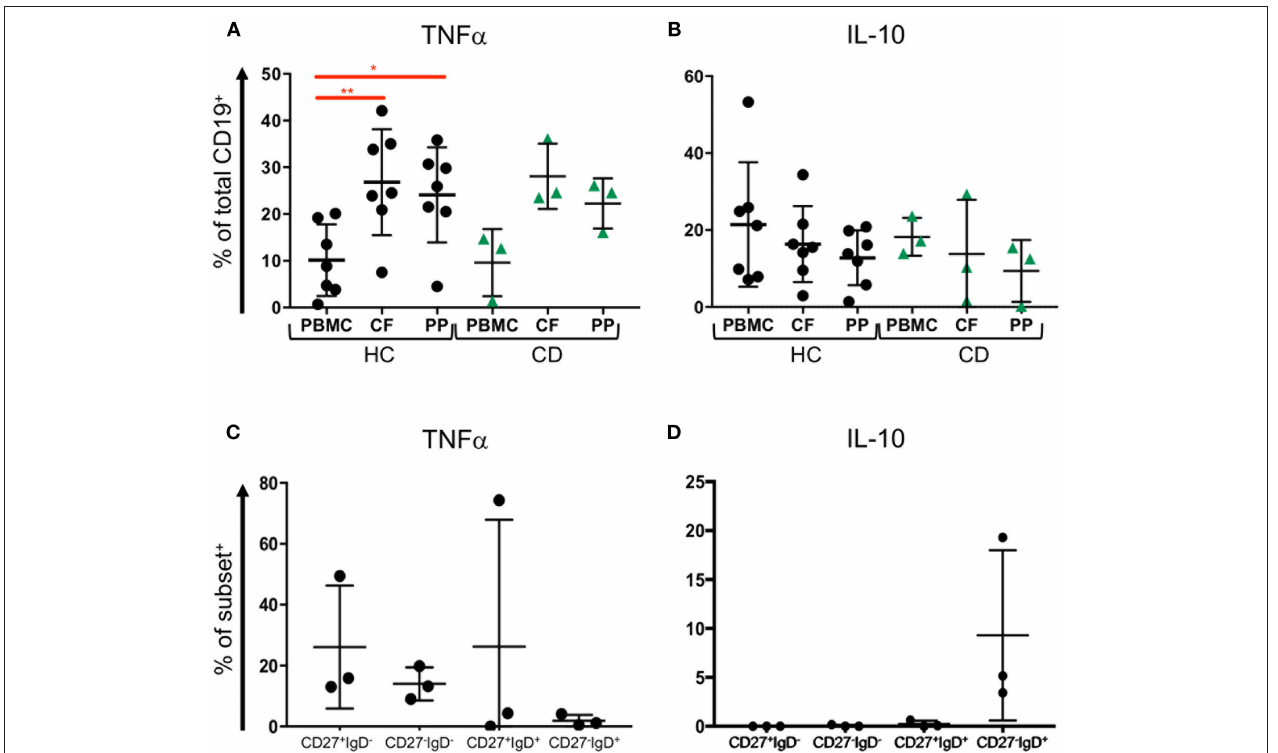
FIGURE 6 | TNF α and IL-10 expression by blood and tissue B cells. Blood (PBMC) and GALT (CF, colonic follicles; PP, Peyer’s patches) samples were obtained from HC ( n = 7) and CD patients ( n = 3) and isolated CD19 + cells were analyzed for (A) TNF α and (B) IL-10 expression according to the strategy in Supplemental Figure 4 . Subsets of B cells were sorted from blood as in Supplemental Figure 3 , and expression of (C) TNF α and (D) IL-10 measured. Data was analyzed by Kruskal Wallis ANOVA test, where p < 0.05 = * and p < 0.01 =